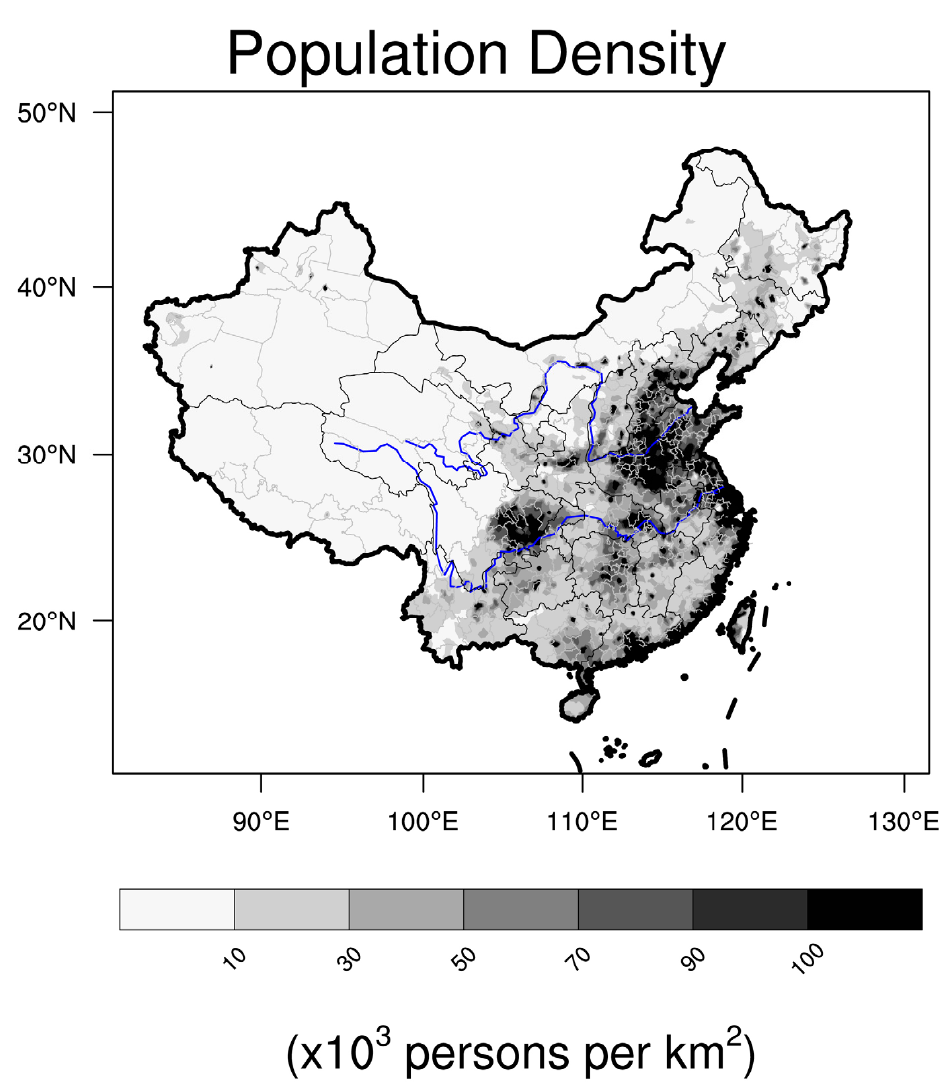
Figure 1. The density of population in China.